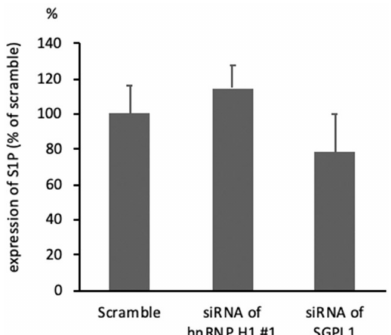
Figure 5. The expression of S1P in hnRNP H1- or SGPL1-downregulated HCT116 cells as assessed by ELISA. ELISA ( n = 3) showed that the intracellular S1P expression was not changed in hnRNP H1- or SGPL1-downregulated HCT116 cells. The error bars show the